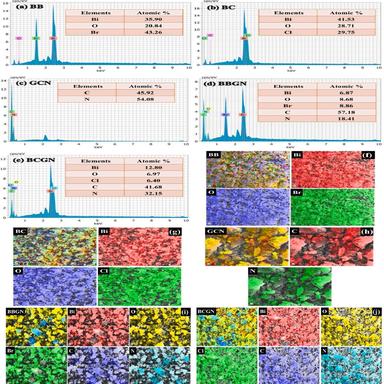
EDAX spectra of (a) BB, (b) BC, (c) GCN, (d) BBGN, (e) BCGN and elemental mapping of (f) BB, (g) BC, (h) GCN, (i) BBGN, (j) BCGN nanocomposite.